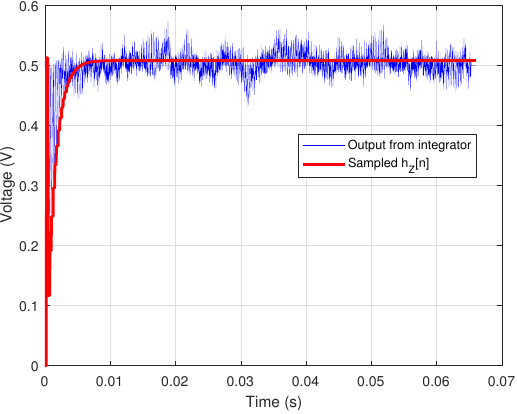
Figure 13. Integrator’s output voltage (blue curve) and its sampled replica (red curve).